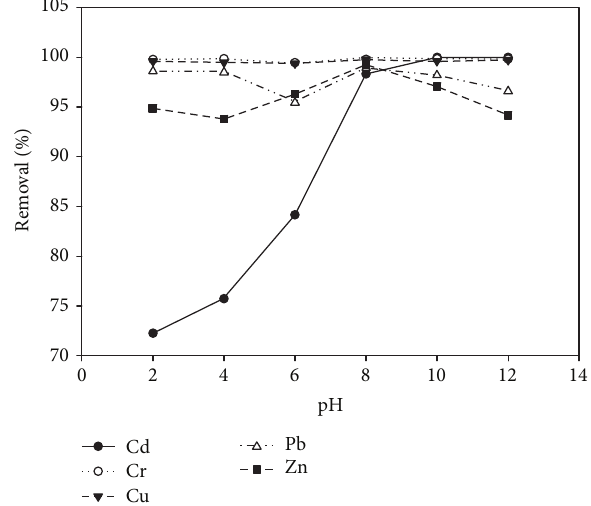
Figure 3: Percentage of heavy metals adsorbed plus any precipitated species at different pH for multicomponent adsorption scenario